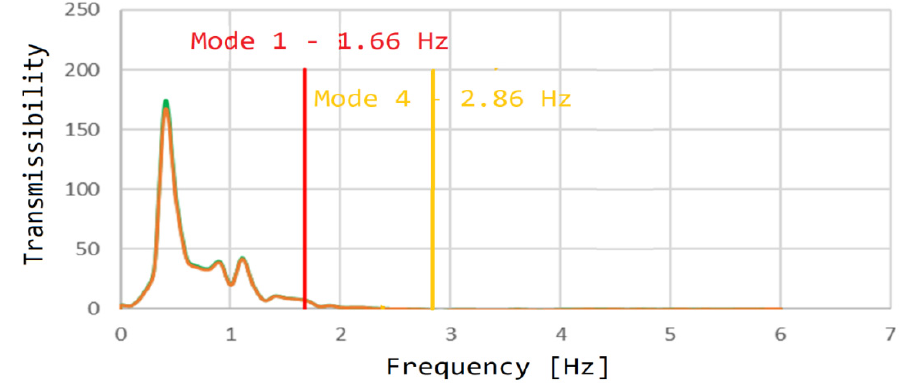
Figure 15. Distribution of the vertical displacements around points 1 and 2.